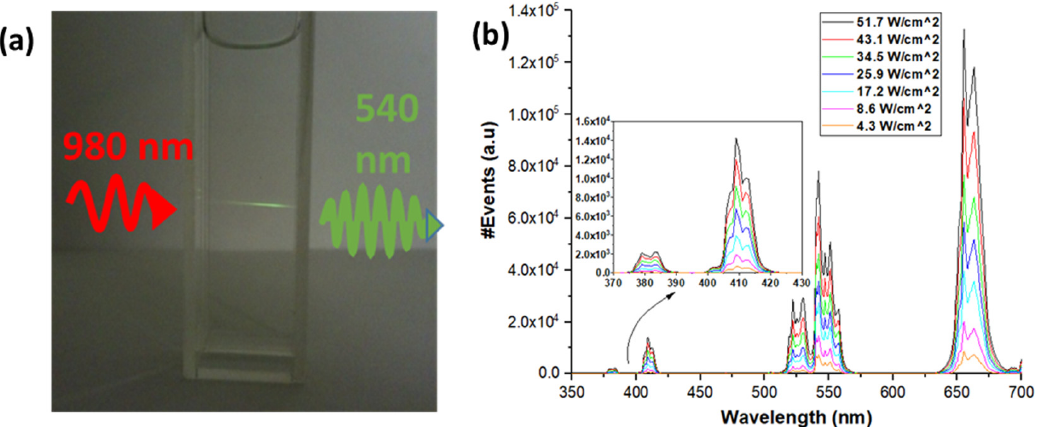
Figure 2. ( a ) Illustration of NIR-green light upconversion; ( b ) emission profile of bulk NaYF 4 :(20%)Yb 3+ , (3%)Er 3+ phosphor at different 980 nm laser excitation powers densities.